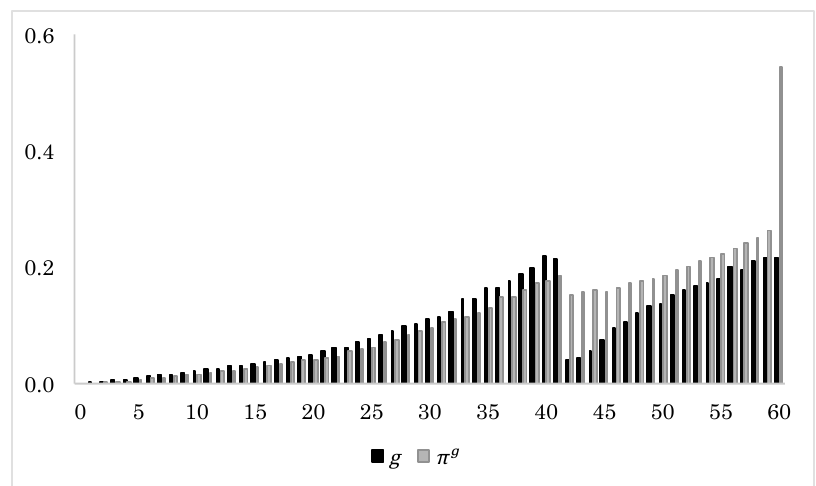
Figure 6. Approximated expected guarantee injection g and guarantee fee π of time.